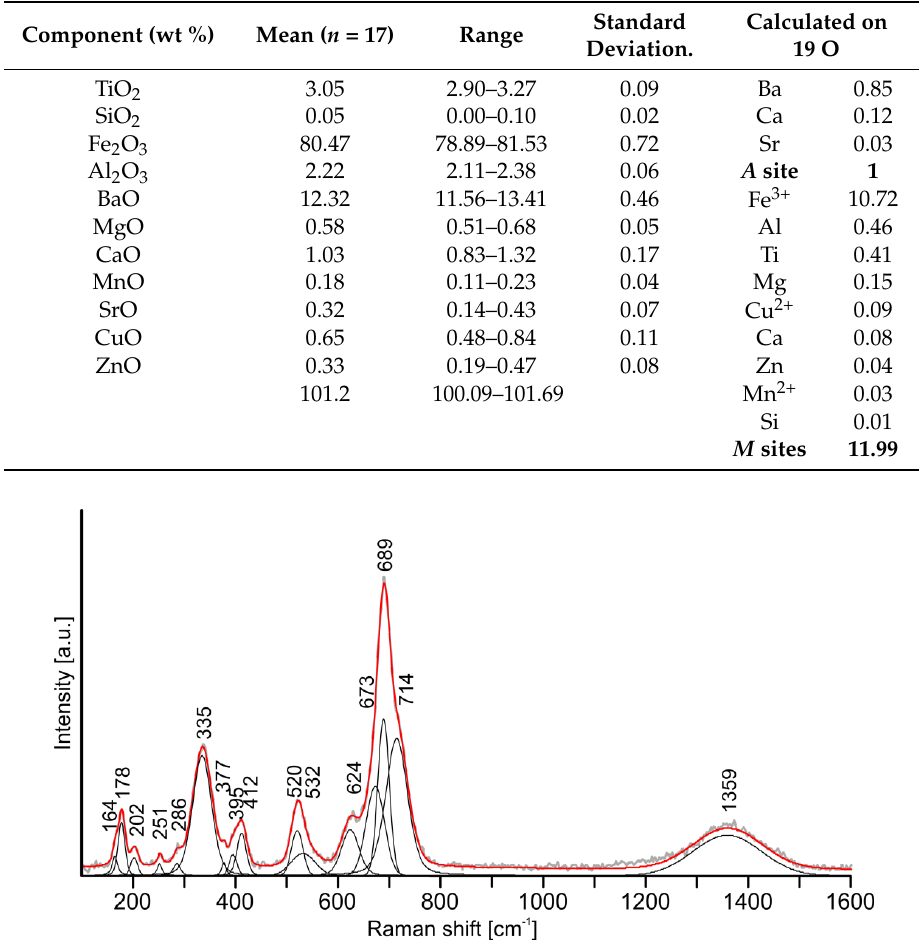
Figure 2. Raman spectrum of barioferrite from Har Parsa; grain is shown in Figure Table 2. Chemical composition of barioferrite from Har Parsa.